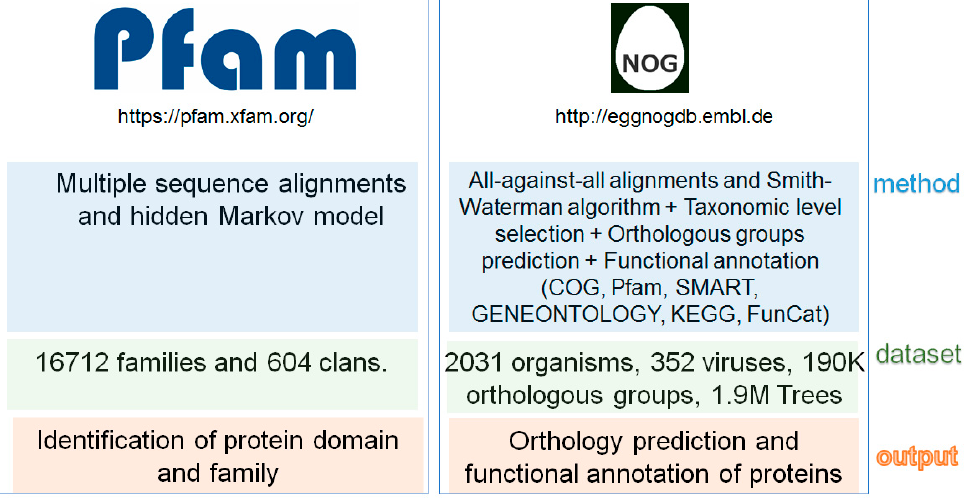
Figure 2. Comparison between Pfam and EggNog databases.